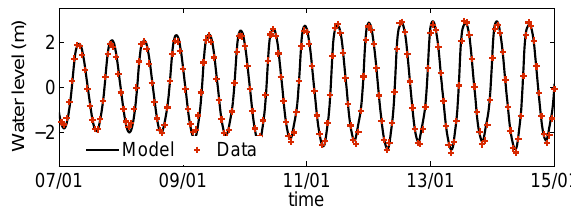
Fig. 3. Time series of predicted tide (based on data analysis done by the French Hydrographic Service, SHOM, 2009) and modelled tide (based on the MARS model and FES2004 forcing at the model boundaries). Site: Dunkerque.